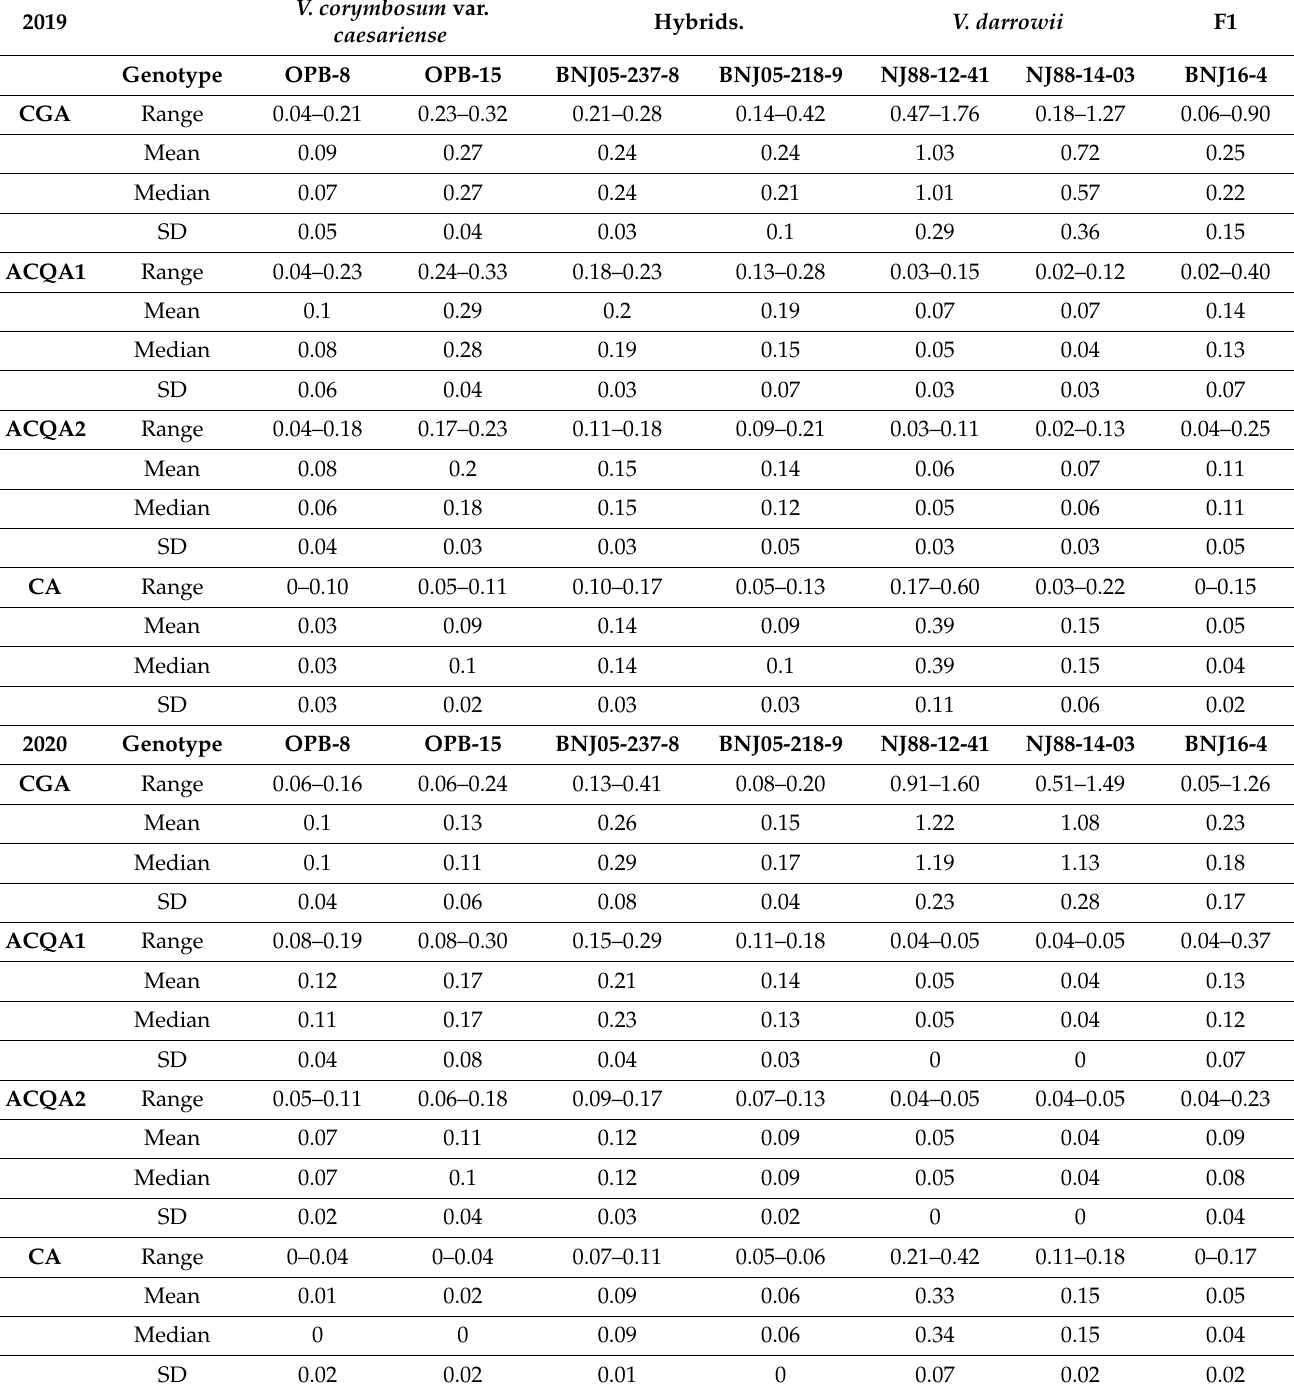
Table 2. Mean, median, standard deviation, and range of phenolic acid concentrations (mg/g fresh weight) in blueberry fruit harvested in 2019 and